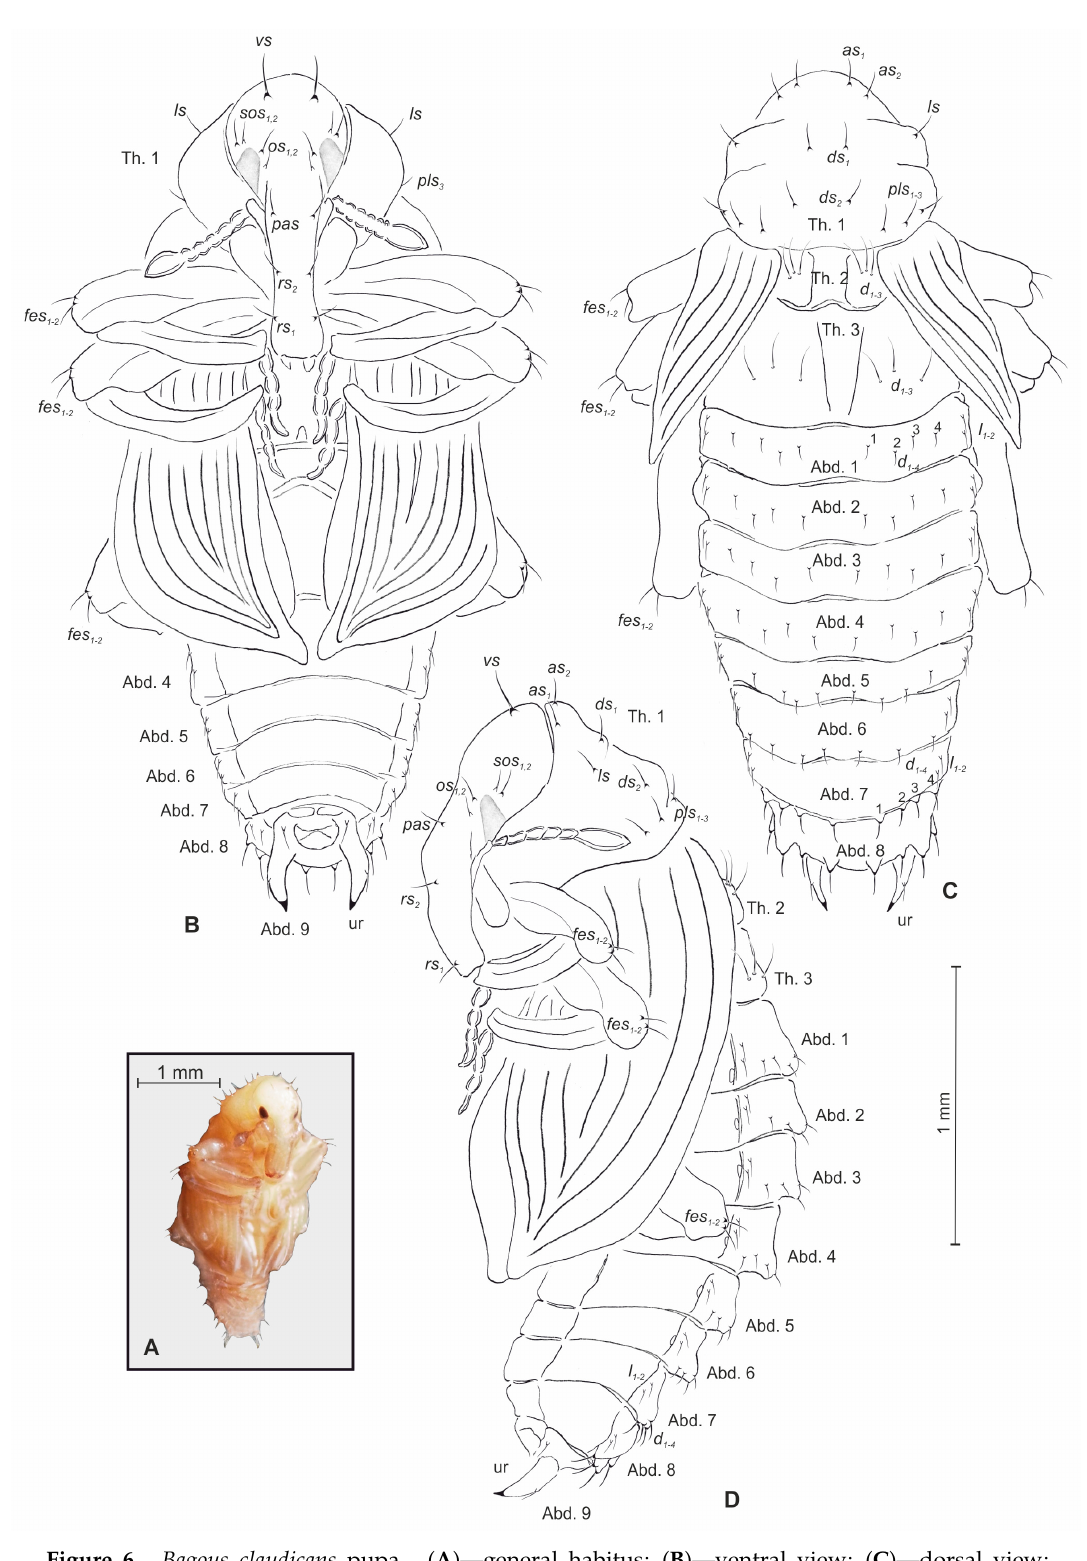
Figure 6. Bagous claudicans pupa. ( A )—general habitus; ( B )—ventral view; ( C )—dorsal view; ( D )—lateral view (Th. 1–3—pro–, meso– and metathorax, Abd. 1–9—abdominal segments 1–9, ur—urogomphus, setae: as —apical, d —dorsal, ds —discal, fes —femoral, l , ls —lateral, os —orbital, pas —postantennal, pls —posterolateral, rs —rostral, sos —superorbital, vs —vertical).